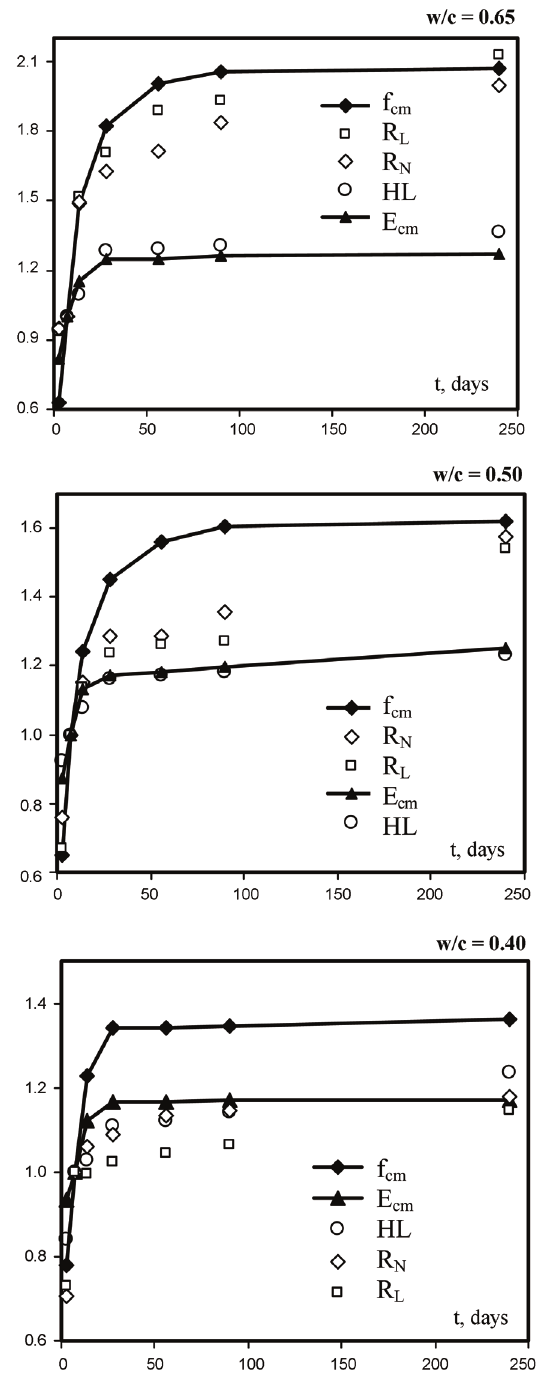
Fig. 3. Relative values of the tested parameters in the function of time In Figure 3 the relative values (referring to the val- ues obtained at the age of 7 days) of all tested parameters are represented over time